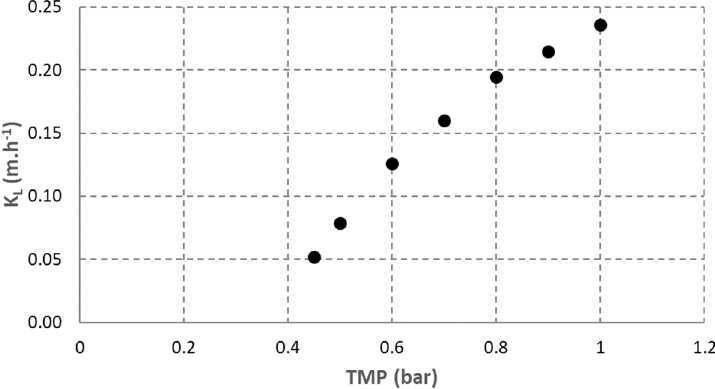
Figure 2. Measurement of membrane mass transfer coefficient at different gas injection pressure.